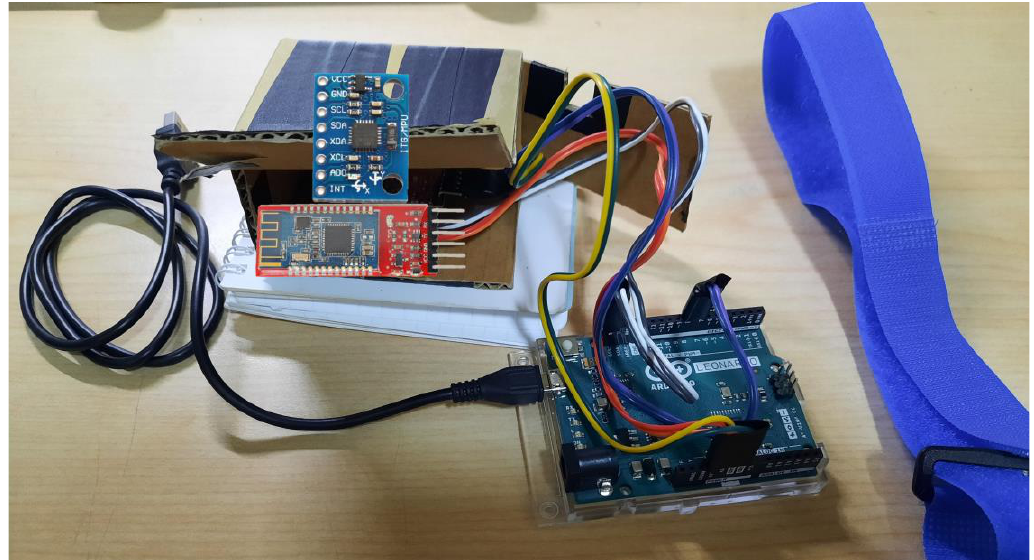
Figure 3. Hardware of CPGAFDWD.